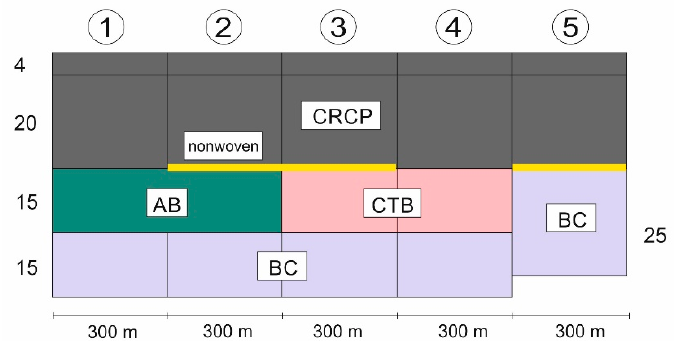
Figure 4. Longitudinal section of motorway A5 Darmstadt. AB: asphalt base layer, CTB: cement bound base layers (hydraulically bound), and BC: stabilization bounded cement.